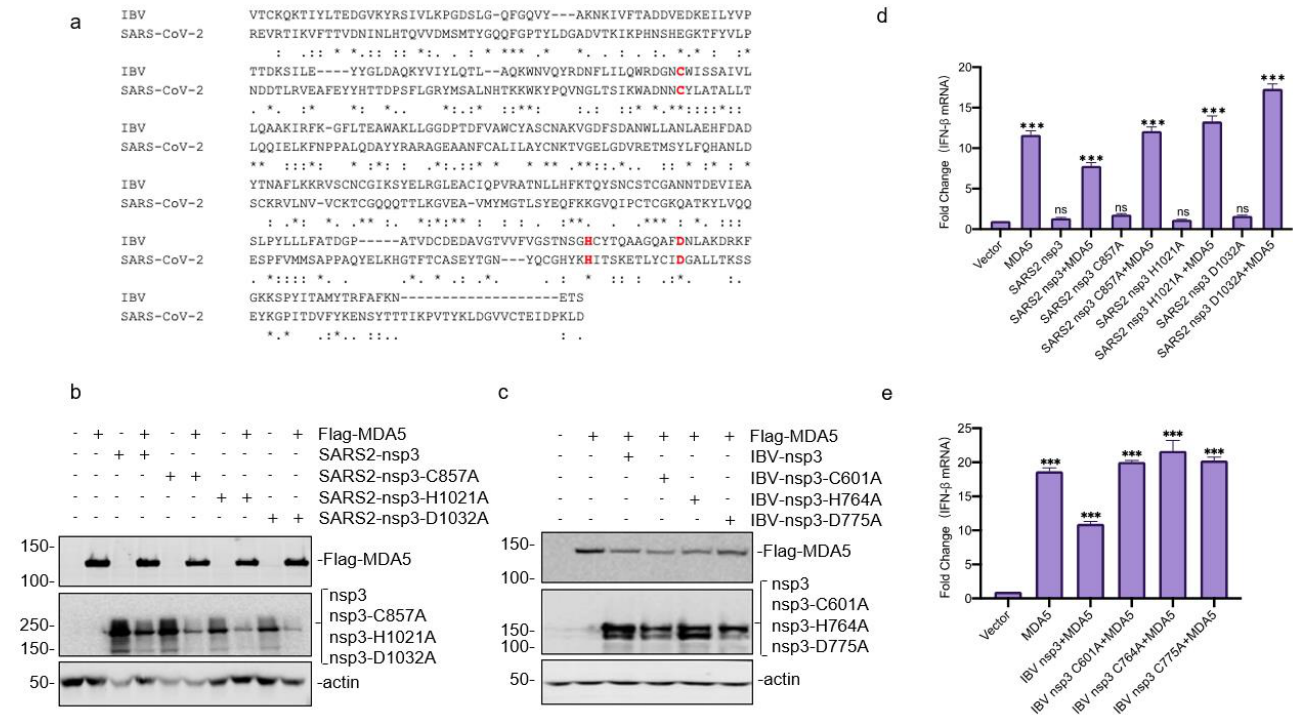
Figure 5. Requirement of the catalytic activity of the PLpro domain for suppressing the MDA5- mediated IFN- β induction. ( a ) Alignment of the PLpro regions from IBV and SARS-CoV-2 nsp3. The alignment was produced using Mafft and sequences obtained from NCBI. The catalytic triad, as well as residues mutated in this study, are indicated in red. ( b ) Western blot analysis of the expression of Flag-MDA5 co-transfected with Hibit-tagged wild-type and mutant SARS-CoV-2 nsp3. HEK293T cells were transfected either with Flag-MDA5 alone or together with Hibit-tagged wild- type or mutant SARS-CoV-2 nsp3. Cells were harvested at 24 h post-transfection and subjected to Western blot analysis with anti-FLAG and anti-Hibit antibodies, respectively. Beta-actin was included as the loading control. Sizes of protein ladders in kDa are indicated on the left. ( c ) Western blot analysis of the expression of Flag-MDA5 co-transfected with Hibit-tagged wild-type and mutant IBV nsp3. HEK293T cells were transfected either with Flag-MDA5 alone or together with Hibit- tagged wild-type or mutant IBV nsp3. Cells were harvested at 24 h post-transfection and subjected to Western blot analysis with anti-FLAG and anti-Hibit antibodies, respectively. Beta-actin was included as the loading control. Sizes of protein ladders in kDa are indicated on the left. ( d ) Effects of co-expression of MDA5 and wild-type or mutant SARS-CoV-2 nsp3 on the MDA5-mediated IFN- β induction. Total RNA was extracted from cells harvested in ( b ), and IFN- β levels were determined by RT-qPCR after normalization with the GAPDH mRNA extracted from cells transfected with the empty vector. Significance levels were presented by the p -value (ns, non-significance, *, p < 0.05; **, p < 0.01; ***, p < 0.001). € Effects of co-expression of MDA5 and wild-type or mutant IBV nsp3 on the MDA5-mediated IFN- β induction. Total RNA was extracted from cells harvested in ( c ), and IFN- β levels were determined by RT-qPCR after normalization with the GAPDH mRNA extracted from cells transfected with the empty vector. Significance levels were presented by the p -value (ns, non-significance, *, p < 0.05;**, p < 0.01; ***, p < 0.001).